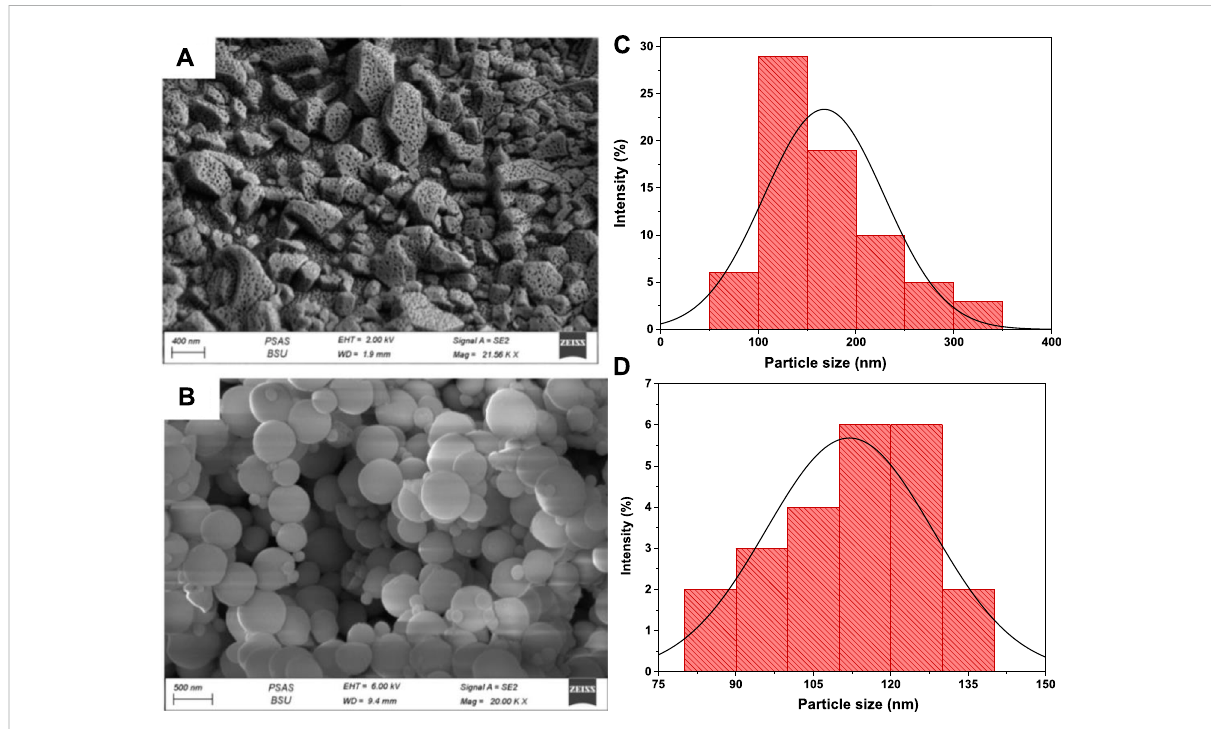
FIGURE 3 FESEM images of UiO-66 (A) and CoFe 2 O 4 @UiO-66 composite (B) ; UiO-66 particle size distribution of UiO-66 (C) and CoFe 2 O 4 @UiO- 66 composite (D)